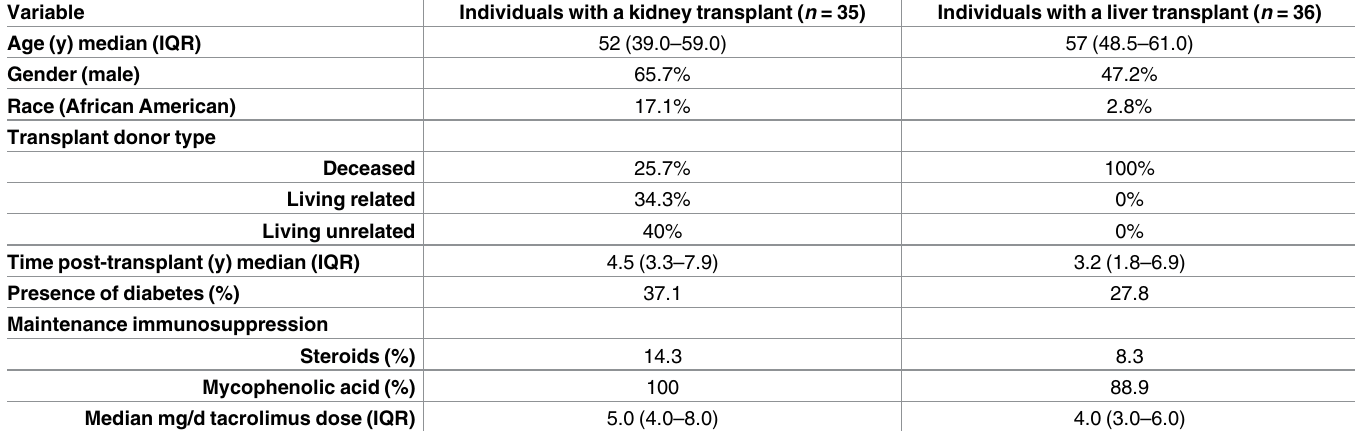
Table 1. Demographic and baseline characteristics of analyzed study individuals with a kidney or liver